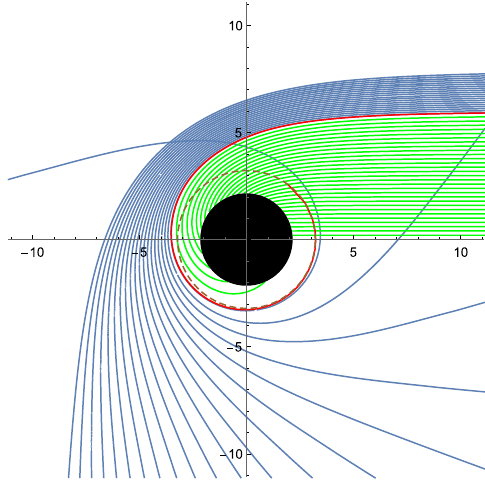
respond to b = b ph , b < b ph and b > b ph respectively. The spacing of the impact parameter is (cid:9) b = 1 / 5 for each light ray. The black hole is shown as the solid black disk and the photon orbit as a dashed line